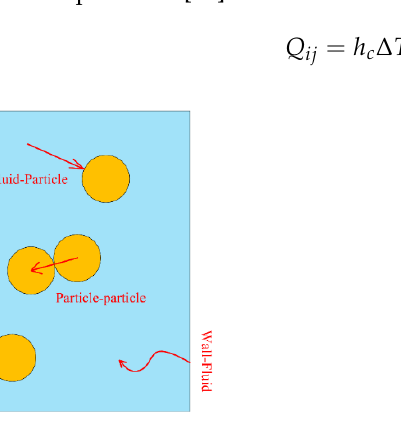
Figure 1. Heat exchange mechanisms in a fluid – solid system.